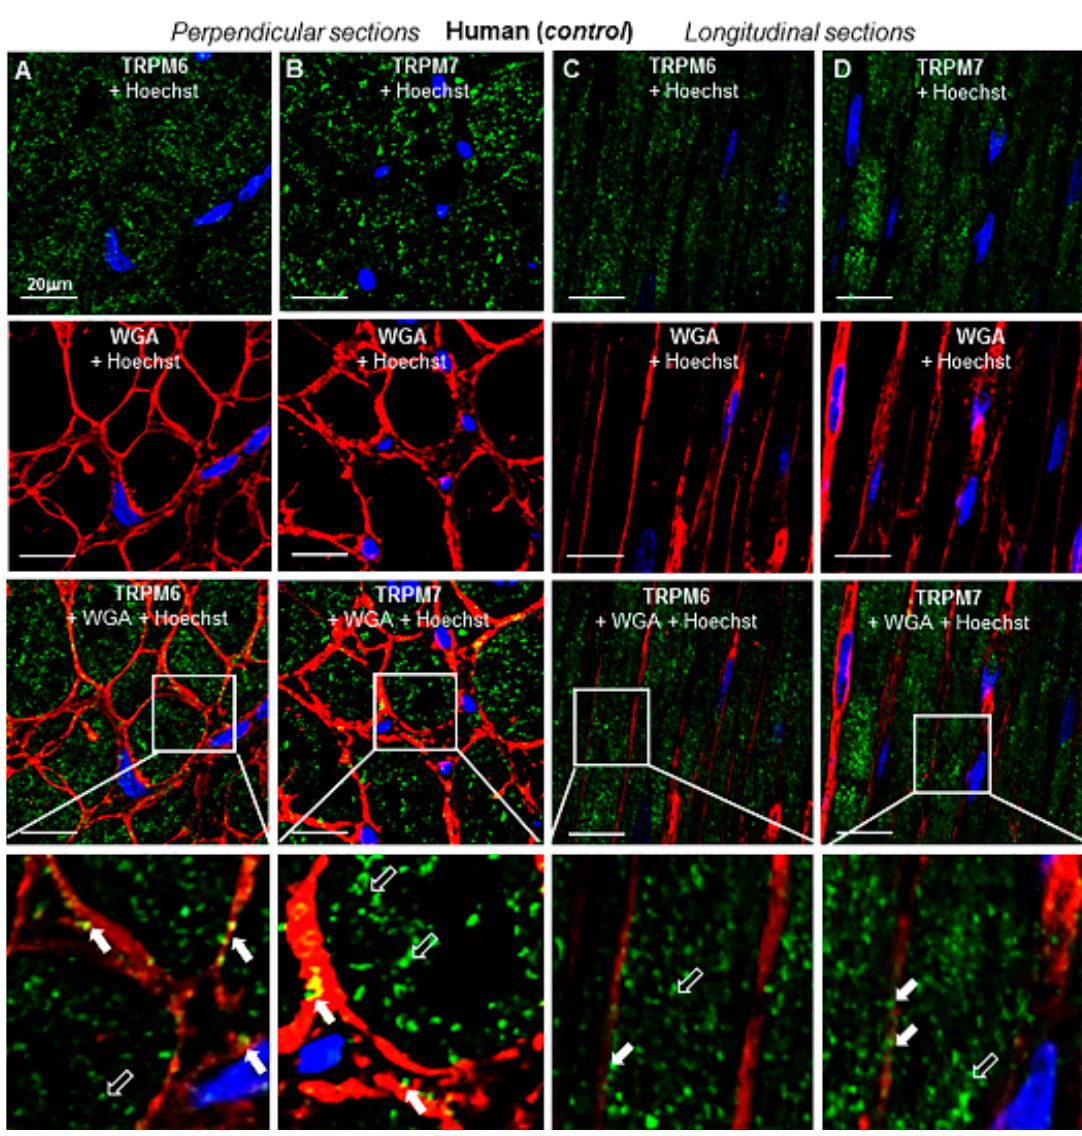
Figure 6. Tissue-level and subcellular localization of TRPM6 and TRPM7 by immunohistochemistry in the RA of an undiseased human heart from car victim. ( A – D ) Confocal microscopy images obtained from perpendicular ( A , B ) and longitudinal ( C , D ) tissue slices. Images shown at higher magnification in the lower panels correspond to zoomed-in areas delimited by squares at a lower scale in the upper panels. TRPM6 and TRPM7 proteins were detected with AF-488-conjugated antibodies (green), the cell surface was labeled with AF-555 for wheat germ agglutinin (WGA, in red), whereas the nucleus staining (with Hoechst 33342) appears in blue. Notice that TRPM6 and TRPM7 are detected both at the cell membrane (filled arrows) and intracellularly (unfilled arrows). Scale bars indicate 20 µm.